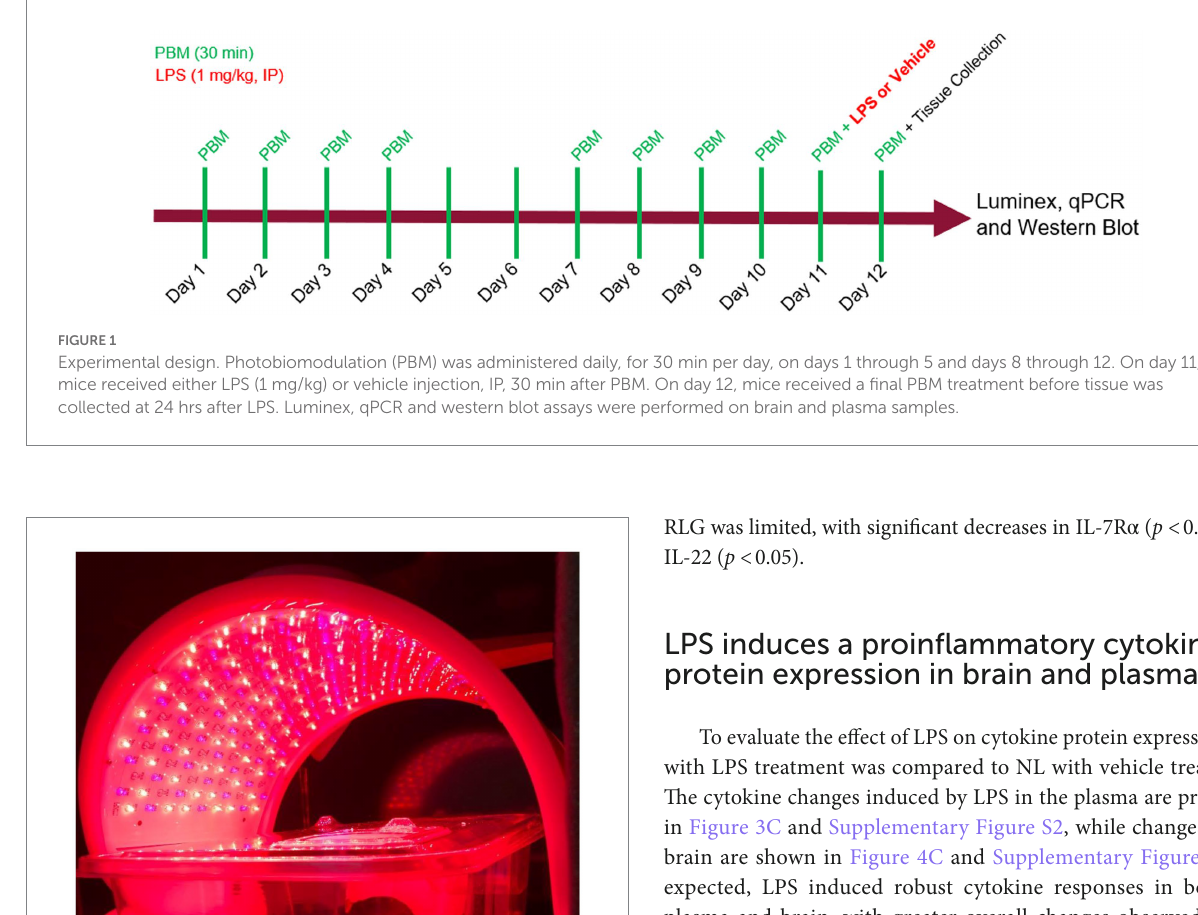
Supplementary Figure S2, while changes in the brain are presented in Figure 4A and select cytokines in Supplementary Figure S3. RL produced mild changes in cytokine expression, with statistically significant differences only in plasma and not the brain, for EOTAXIN/ CCL11 ( p < 0.05) and MCP-3/CCL7 ( p < 0.01). The cytokine changes induced by RLG in the plasma are presented in Figure 3B and Supplementary Figure S2. The changes in the brain are shown in Figure 4B and Supplementary Figure S3. In the plasma, RLG produced an altered pattern of cytokine expression, which included statistically significant changes in IL-23 ( p < 0.05), IL-17A ( p < 0.05), and EOTAXIN/CCL11 ( p < 0.05). In the brain, the cytokine response to